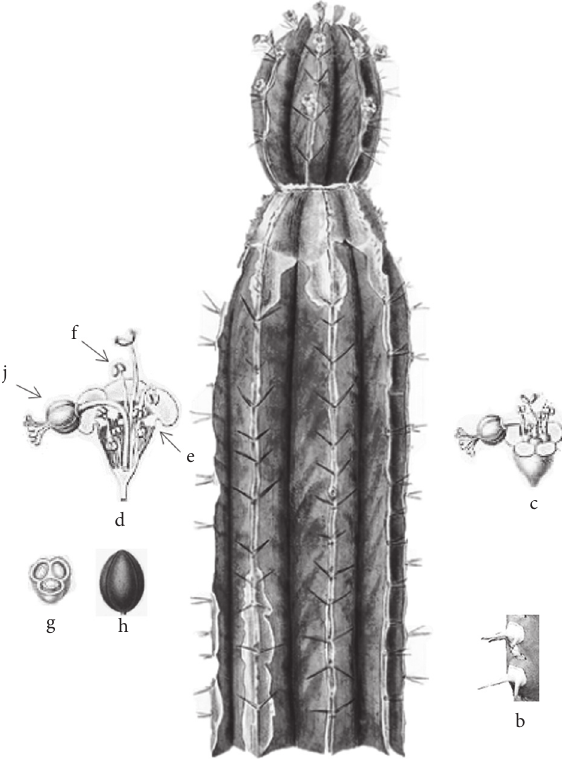
Figure 2: The different parts of a stem of E. officinarum L. (a) E. officinarum L., (b) thorns, (c) inflorescence, (d) vertical section of inflorescence, (e) involucre, (f) sterile flower, (j) fertile flower, (h) ovary, and (g) longitudinal section of ovary (http://www.